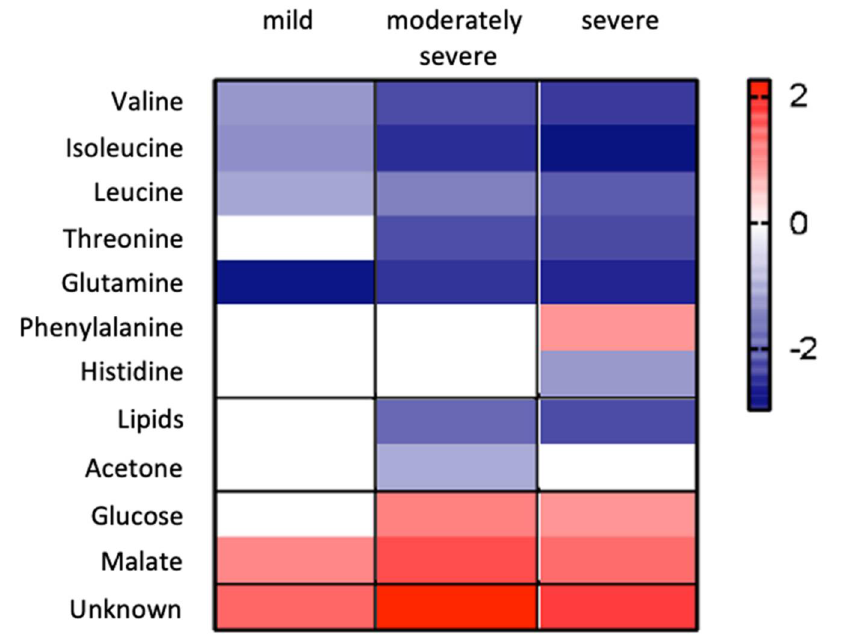
Figure 6. Heatmap of effect sizes representing plasma metabolome changes associated with severe biliary AP patients as compared with healthy control group.